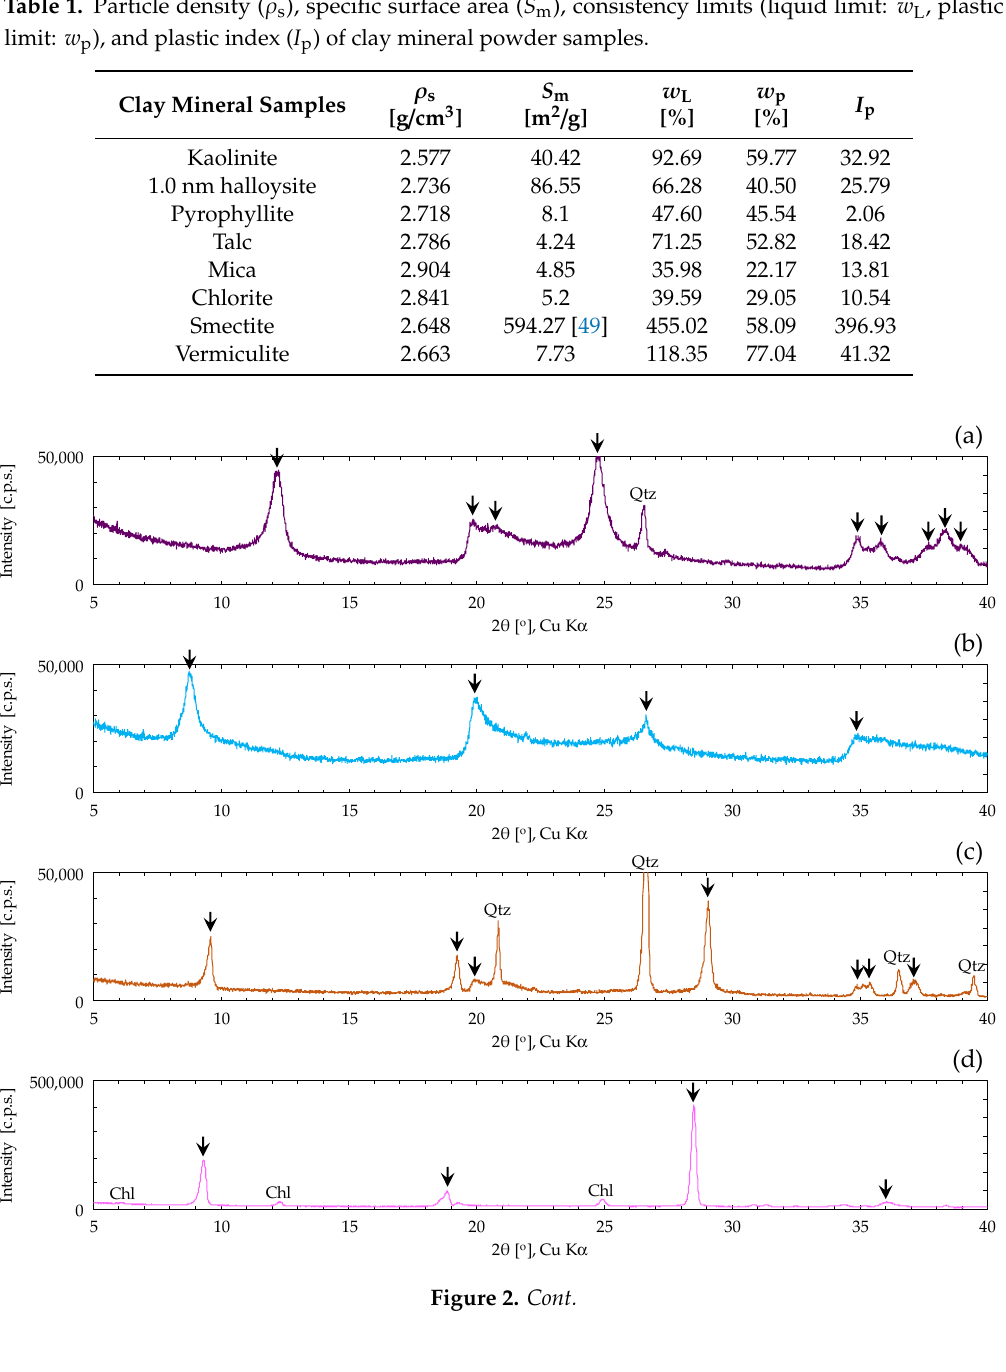
Table 1. Particle density ( ρ s ), specific surface area ( S m ), consistency limits (liquid limit: w L , plastic limit: w p ), and plastic index ( I p ) of clay mineral powder samples.